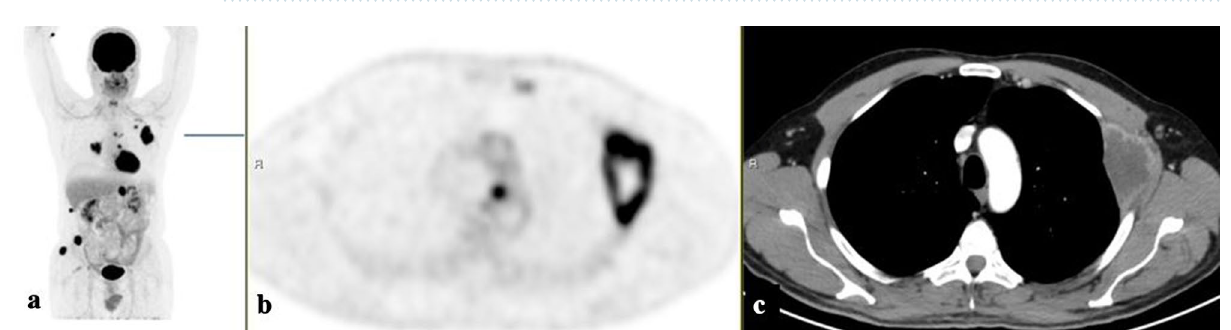
Figure 2. [18F]FDG-PET/CT: maximum intensity projection (MIP), (a) representative PET (b) and CT (c) axial slices. A 49-year-old man with a biopsy-proven poorly-differentiated adenocarcinoma from a chest wall mass (A. b). Multiple sites of [18F]FDG avid lesions in the bones and in the left